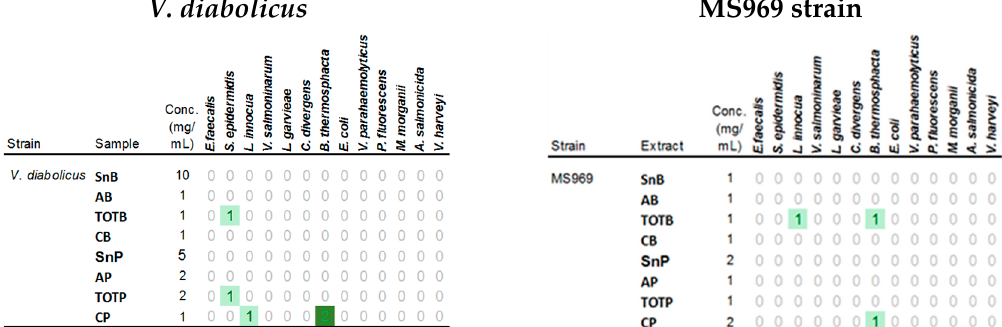
Figure 10. Antimicrobial activities of extracts against 13 indicator strains. 0: no activity; 1: medium activity; 2: high activity.